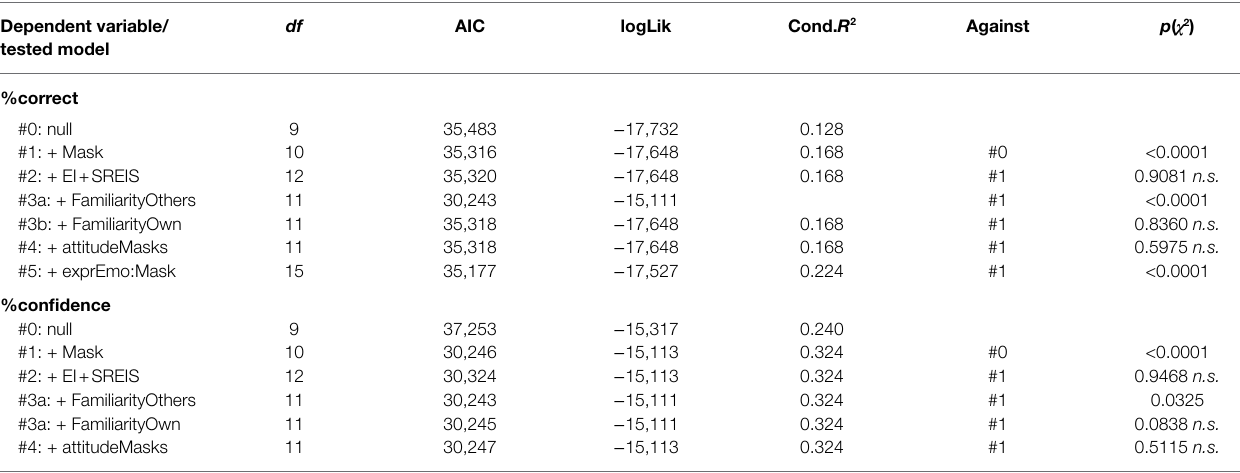
TABLE 1 | Comparison of different linear mixed effects